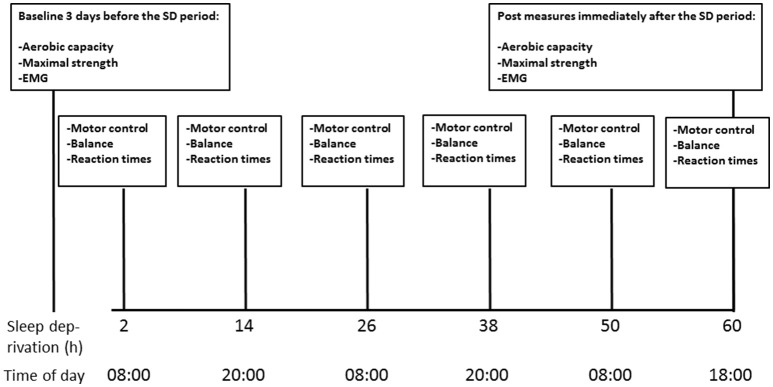
Timeline of the measurements during the 60-h SD period.